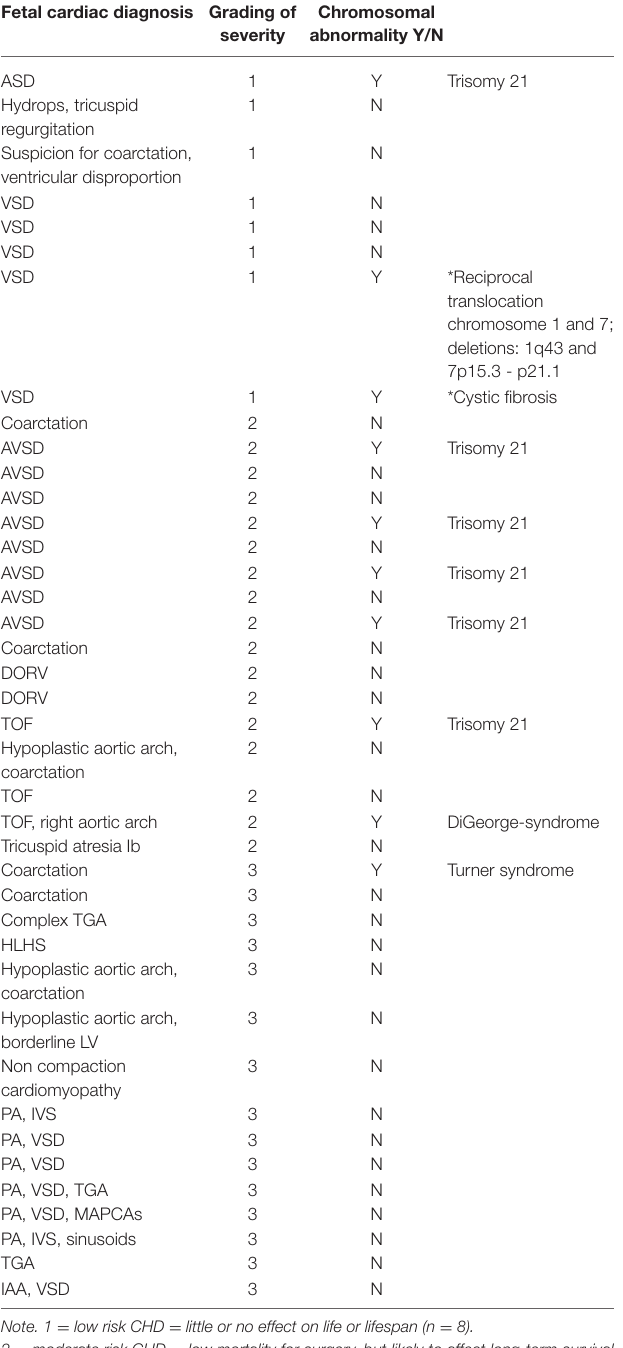
TABLE 1 | Overview of cardiac diagnoses, associated chromosomal abnormalities, and grading of the heart defects [according to Allan and Huggon (6)].